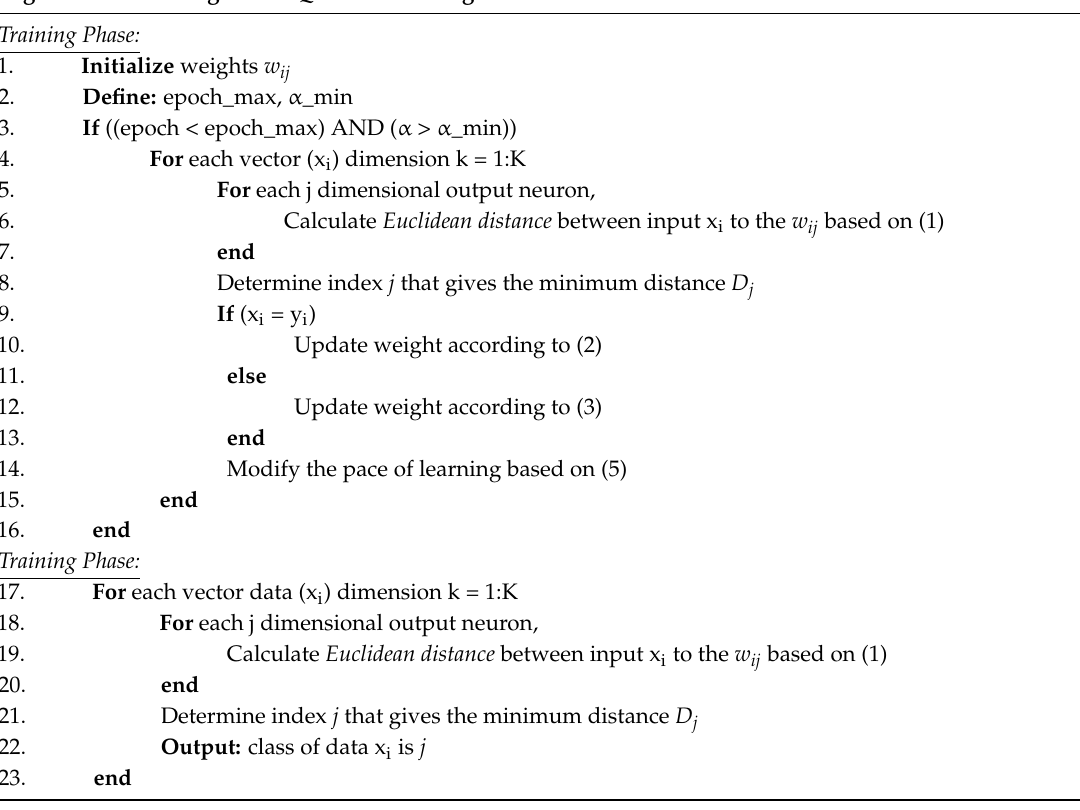
Algorithm 1 Learning Vector Quantization